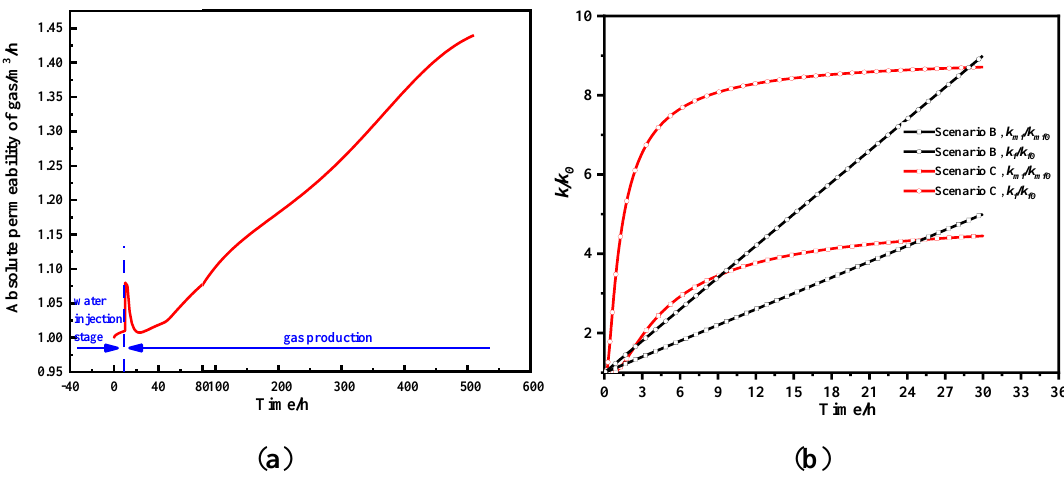
Figure 9. (a) Intrinsic permeability over time (b) Intrinsic permeability variations with injection